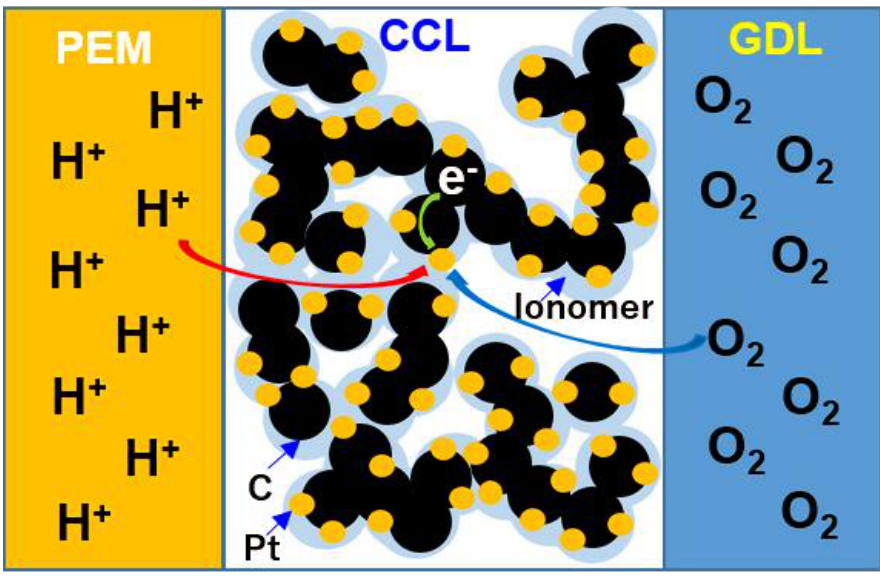
Figure 1. Schematic of the CCL.